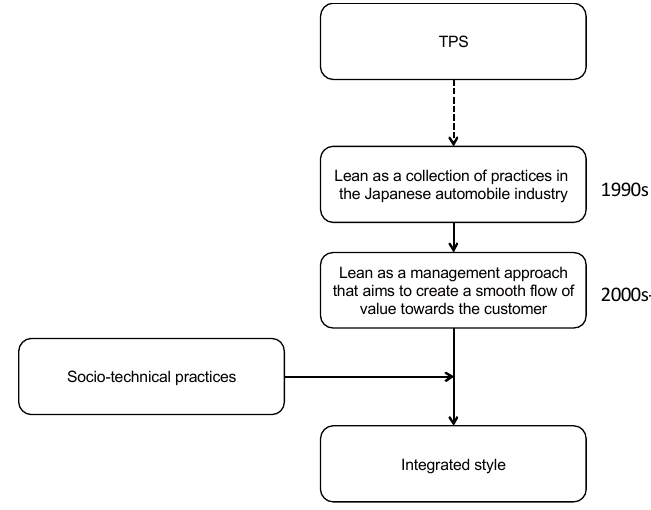
Figure 1. Integration of lean and STS